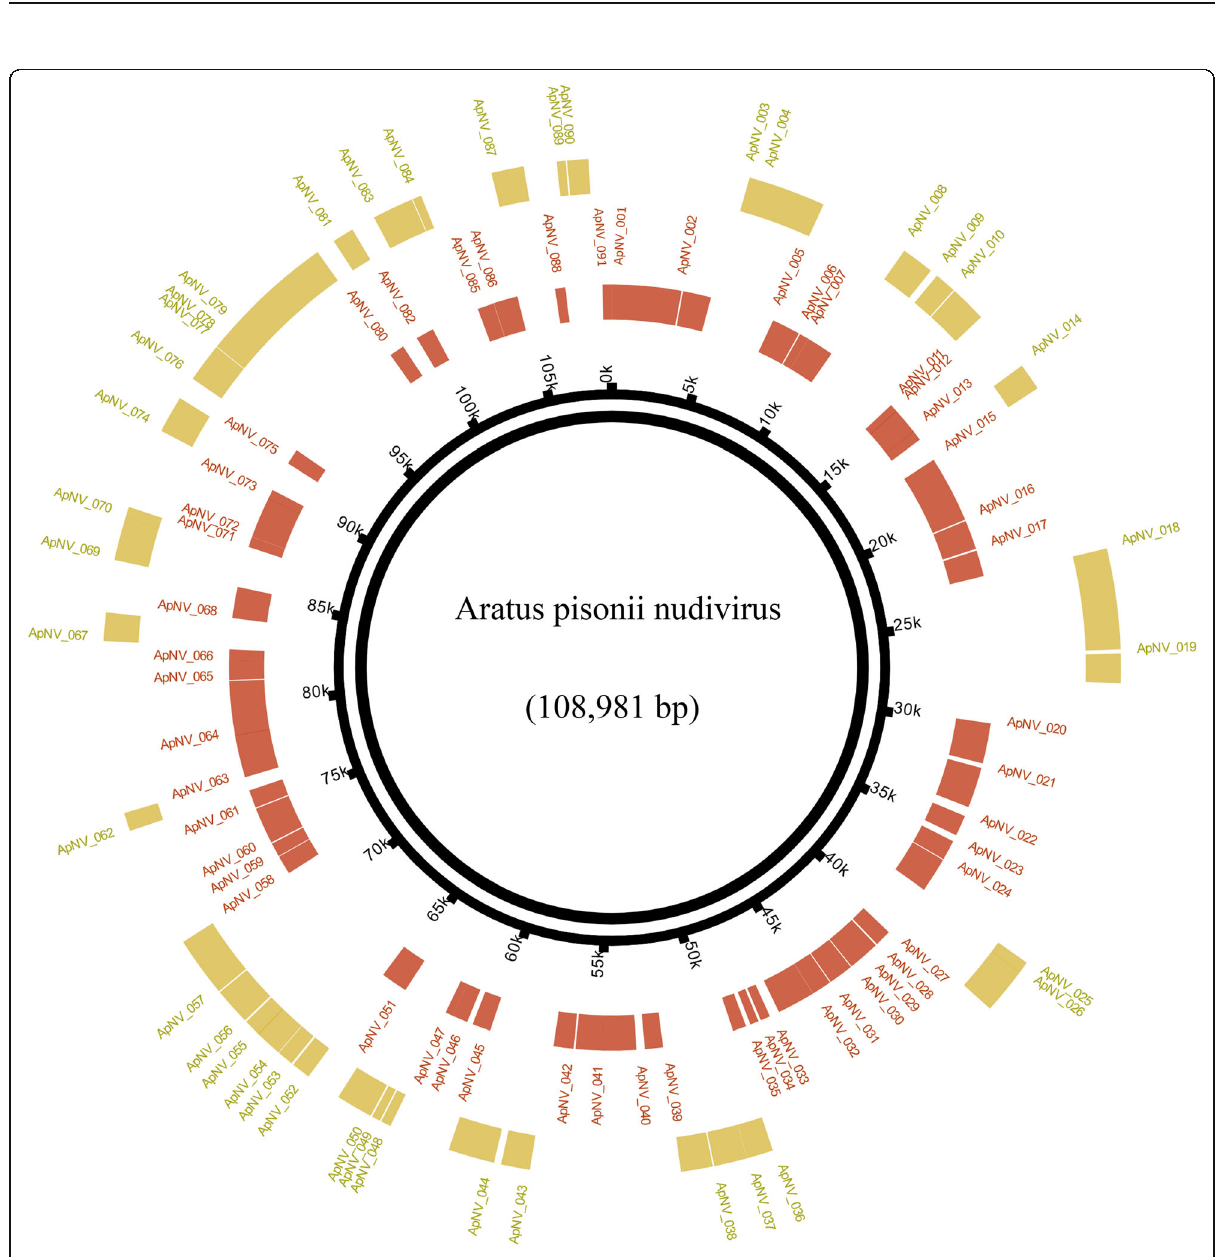
Fig. 3 Aratus pisonii nudivirus (ApNV) genome plot, highlighting negative strand (gold) and positive strand (red) protein coding genes. The ApNV number is listed in the appropriate colour according to the gene it represents and the strand it is present on. The figure was developed using